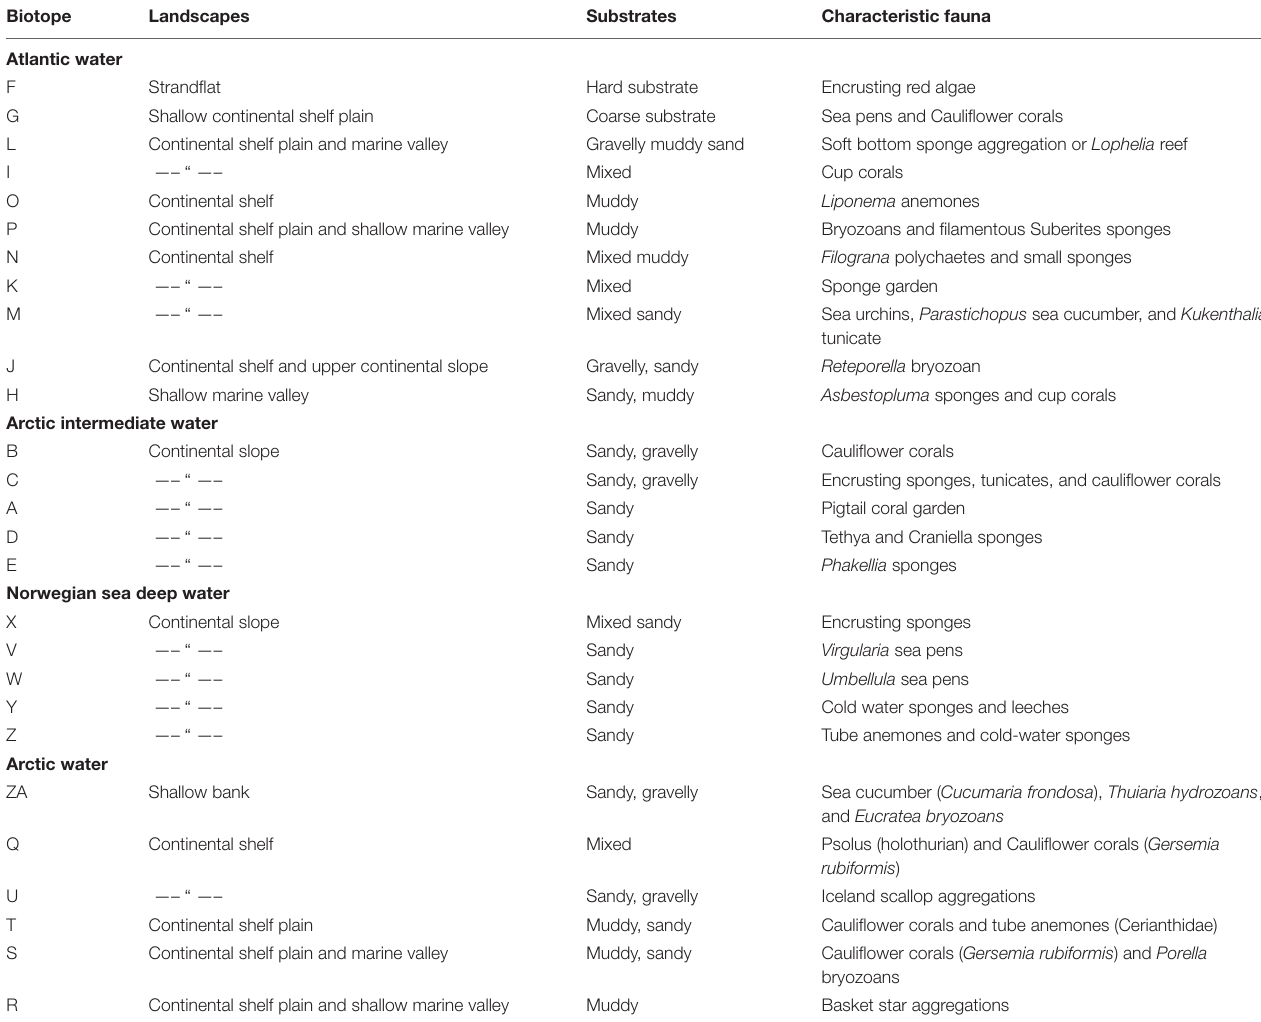
TABLE 2 | List of biotopes, with a brief description of their characteristic water mass, landscapes, sediments, and fauna.